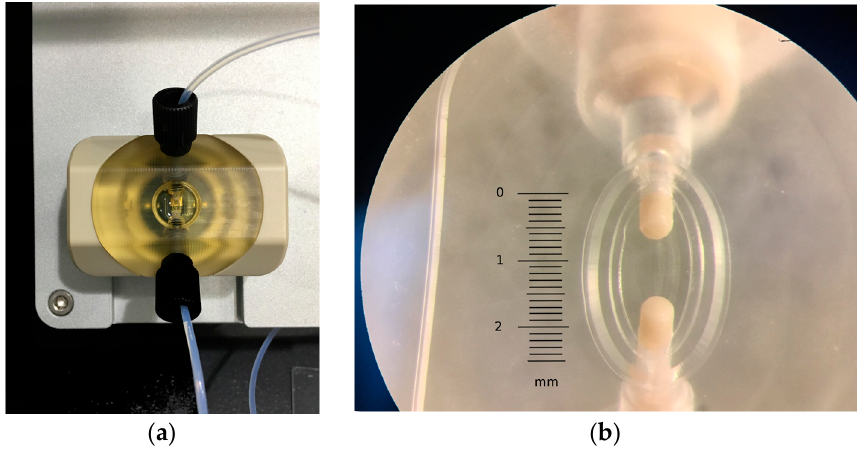
Figure 4. Pictures of ( a ) the measurement cell once assembled in the A20 platform, and ( b ) detailed view of the OSTEMER gasket with the flow chamber, including the flow terminal connections for the fittings.